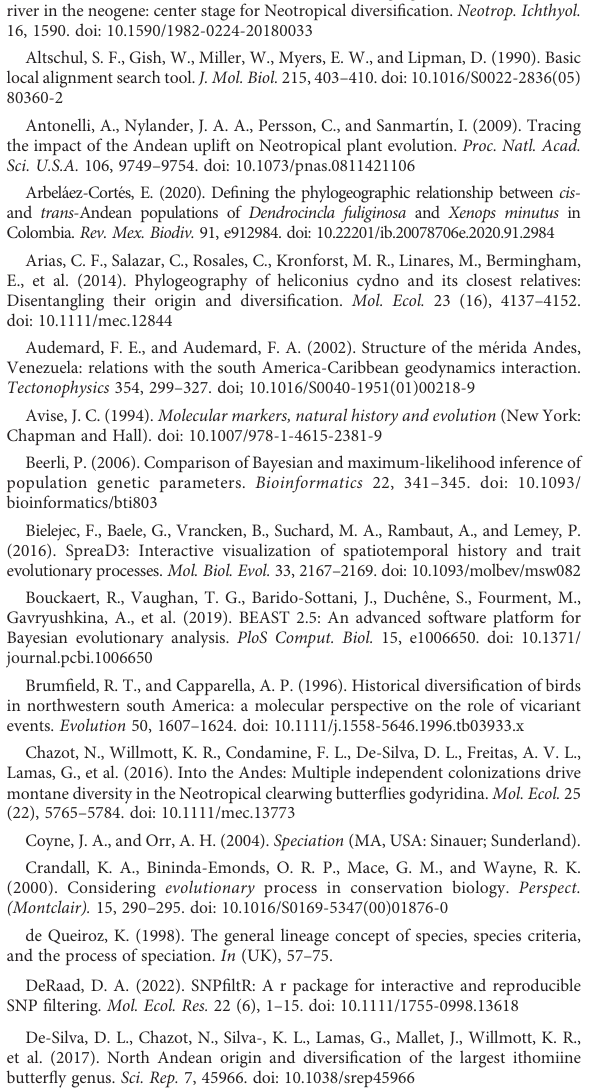
SUPPLEMENTARY FIGURE 2 Bayesian phylogenetic reconstruction of Kinosternon scorpioides from insular (San Andre ́ s) and continental (Caribbean, Orinoco and Amazon) Colombia, using (A) a matrix of 3-4 individuals per population with 383 SNPs containing <10% of missing data, and (B) a matrix of 3-9 individuals per population with 383 SNPs containing <10% of missing data. Both trees were estimated under a GTR+G model of molecular evolution. Maximum Clade Credibility Trees are shown with node supports based on the posterior probability. SUPPLEMENTARY FIGURE 3 Visualization of the optimal number of clusters using multiple methods in the web-based software StructureSelector, after testing K=1-6 in STRUCTURE, for 23 samples of K. scorpioides from four Colombian populations (San Andres, Caribbean, Orinoco and Amazon). (A) Mean LnP(K), identifying K=6 as the most likely number of clusters. (B) Evanno method ( D K), identifying K=2 as the most likely number of clusters. (C)